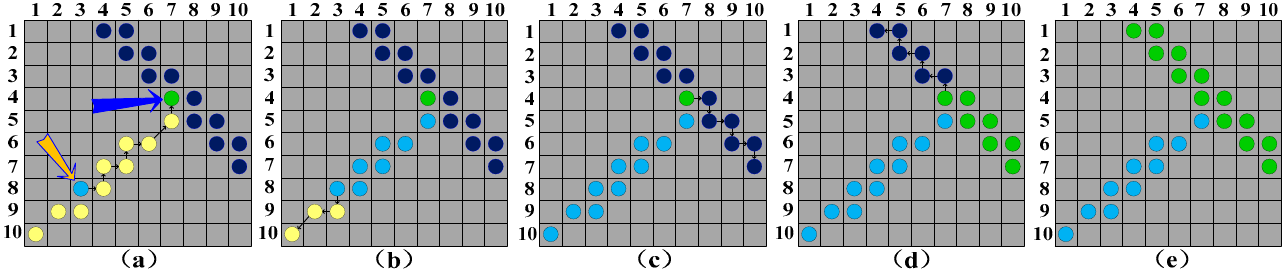
Figure 8. ( a ) is to obtain the seed point of each chain. The blue and green points are the respective seed points of the two chains in the peak gradient direction, and the yellow points indicate other points of the first chain. Dark blue points indicate other points of the second chain ( b ) means starting from the seed point of a chain, detecting the eligible points along a certain direction, and growing the line until it stops when it encounters the next chain. ( c ) Means to start from the seed point again and grow the line in the opposite direction until the detection of all points in the chain that meet the conditions is completed, and the preliminary detection of the line is completed. ( d , e ) is the line detection and growth process of the second chain, the process is the same as that of the first